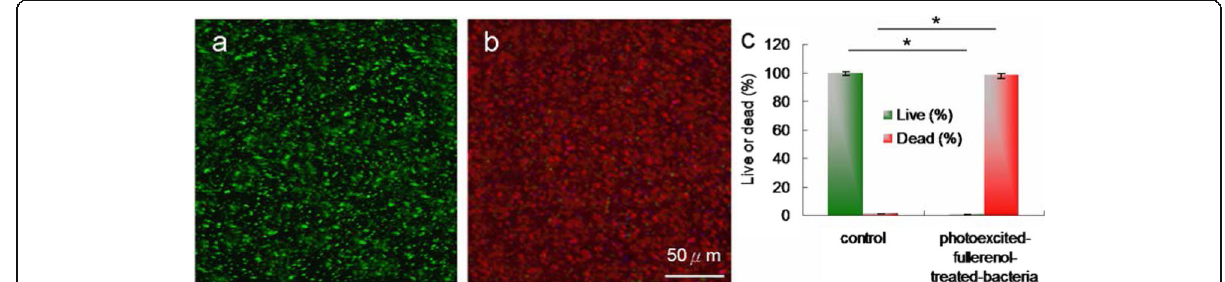
Fig. 6 Images obtained after laser photoexcitation exposure (211.2 nJ pixel − 1 ) with 800 scans (approximately 3.2621 s of total effective exposure time; Ex, 760 nm) of a , b material-treated bacteria. The Live/Dead kit was used to stain bacteria before images were obtained. Scale bar, 50 μ m. c Viability (%) determination results. Delivered dose, OD600 ~ 0.05 of E. coli and 3 μ g mL − 1 water-soluble fullerenol C 60 (OH) 46 . For the percentages